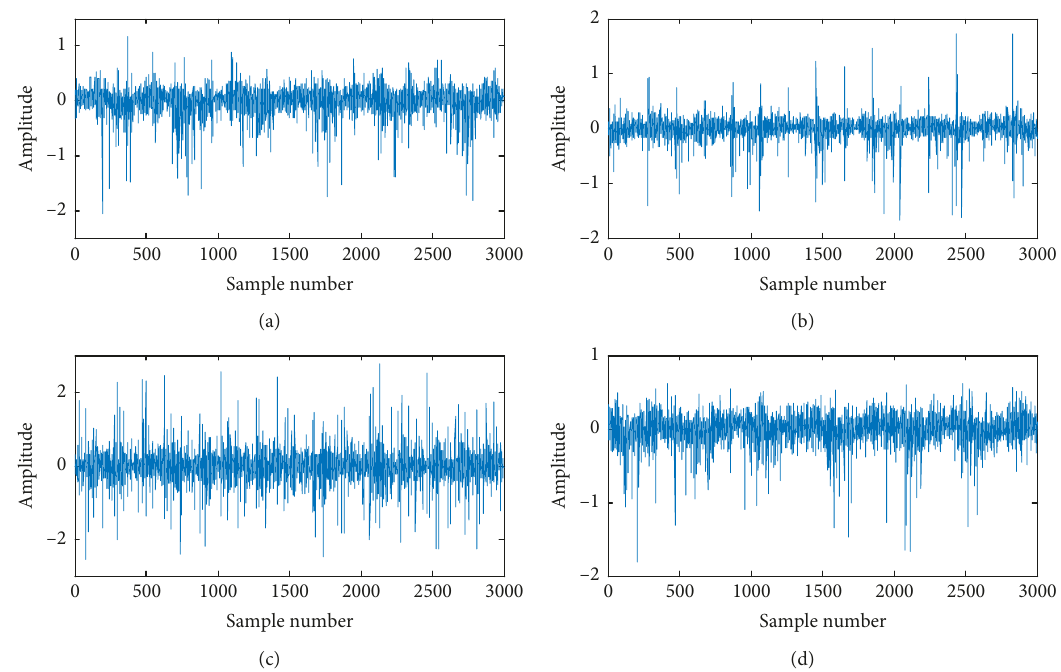
Figure 25: The time domain diagram of the collected signals, where (a)–(d) represent normal gear signal, broken teeth fault signal, pitch errors signal, and wear gear signal, respectively. Each signal is listed with 3000